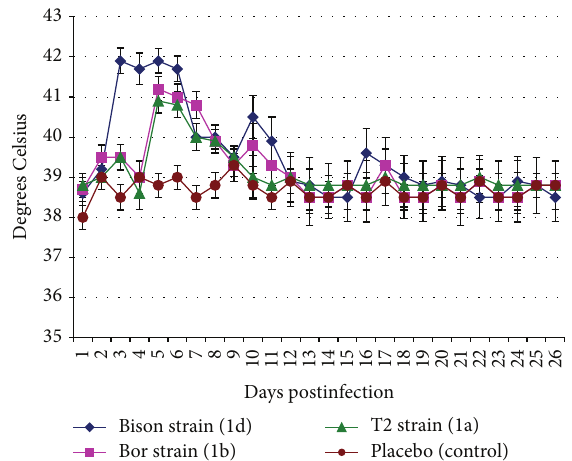
Figure 1: The data on the dynamics of rectal temperature in 4–6- month-old calves after aerosol challenge by bovine viral diarrhea virusdifferentnoncytopathicstrainsoftype1withthedoseof6 log 10 TCD 50 . The values are presented as 𝑀±𝐼 95 ( 𝑀 , mean value; 𝐼 95 , 95% confidence interval) for 𝑛 = 3 , the number of animals per time point (1–10 days postinfection, p.i.); 𝑛 = 2 , the number of animals per time point (11–25 days p.i.); values obtained for the three strains 5–8 days p.i. are higher than in the control according to Mann-Whitney 𝑈 test and Student’s 𝑡 -test at 𝑝 ≤ 0.05 ; values obtained for Bison strain 3–6 days p.i. are higher than for T2 and Bor strains according to Mann- Whitney 𝑈 test and Student’s 𝑡 -test at 𝑝 ≤ 0.05 ; values obtained for Bison strain 10 and 11 days p.i. are higher than for T2 strains according to Mann-Whitney 𝑈 test and Student’s 𝑡 -test at 𝑝 ≤ 0.05